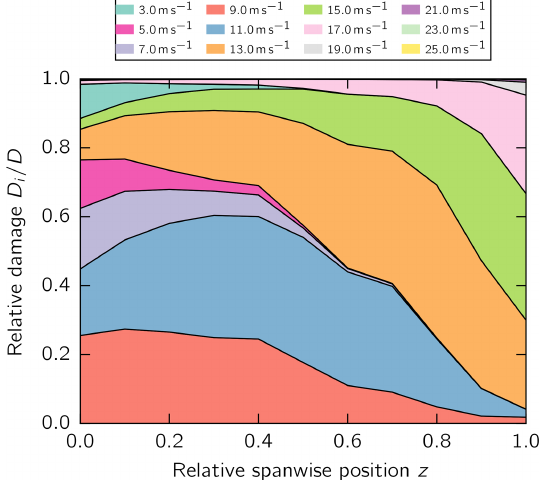
Figure 8. Relative damage from aeroelastic simulation.